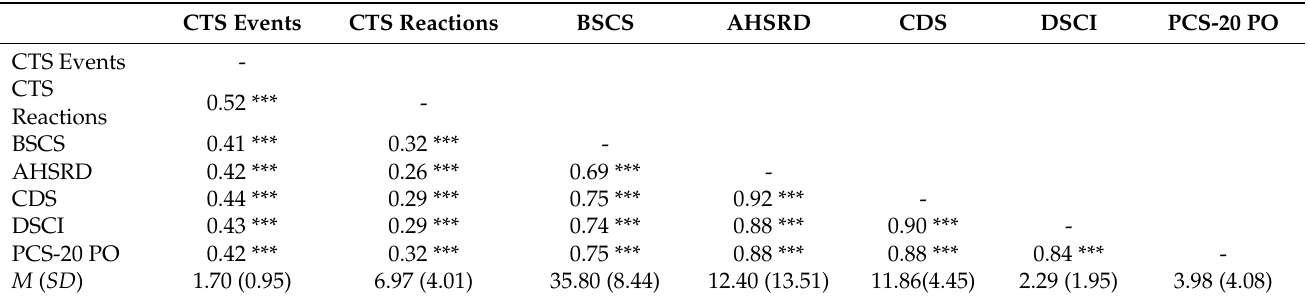
Table 1. Correlation matrix.